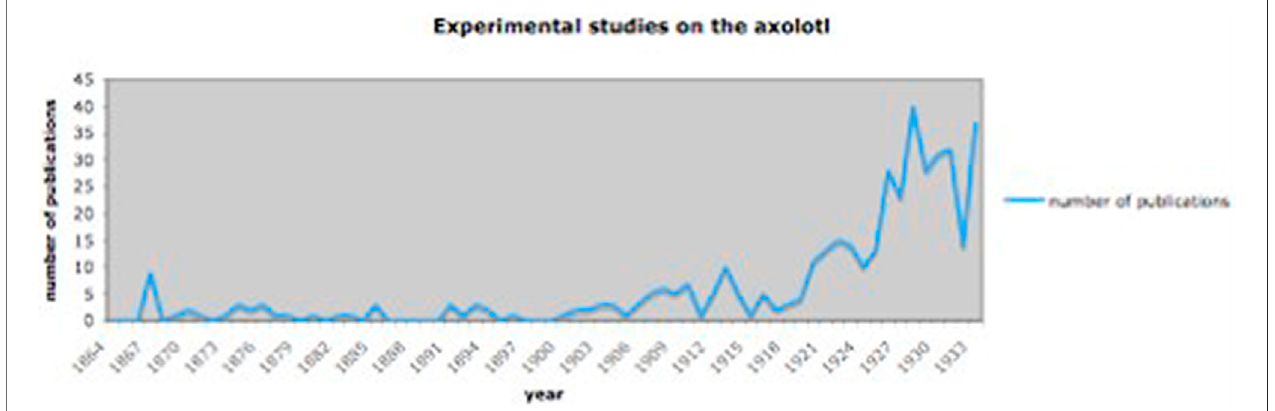
FIGURE 2 | Papers on experiments using the axolotl from 1864 to 1933. For data, see Reiß (2020).